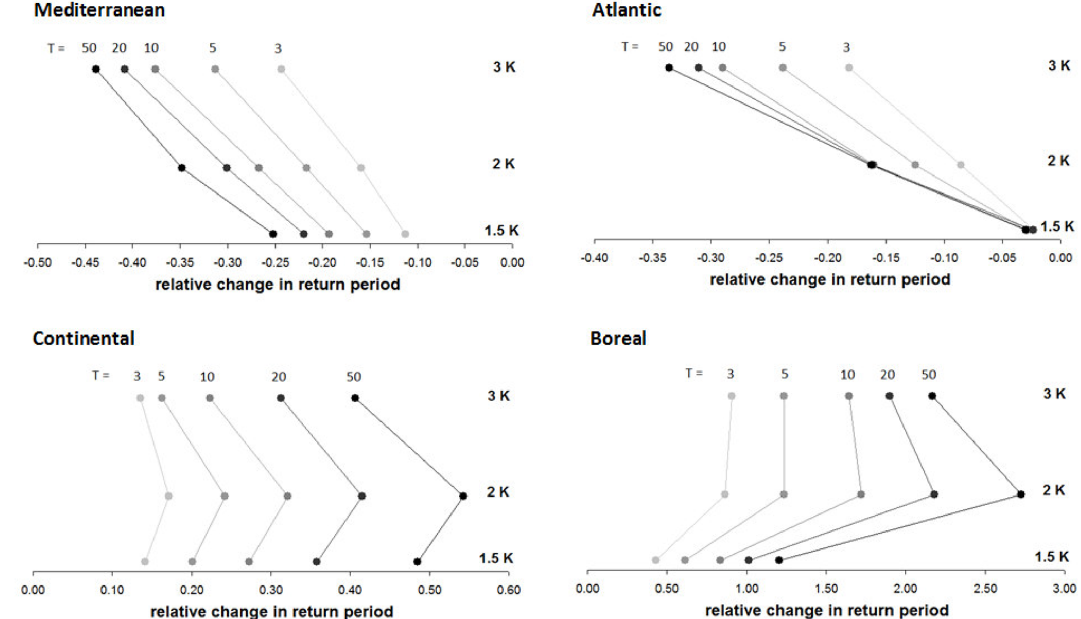
Figure 4. Relative changes in sub-regional median return period (years) for different GWLs corresponding to events with a return period of 3, 5, 10, 20, and 50 years in the reference baseline. Negative (positive) values represent an increase (reduction) in drought frequency. Note that the x axis scale is different for each plot.